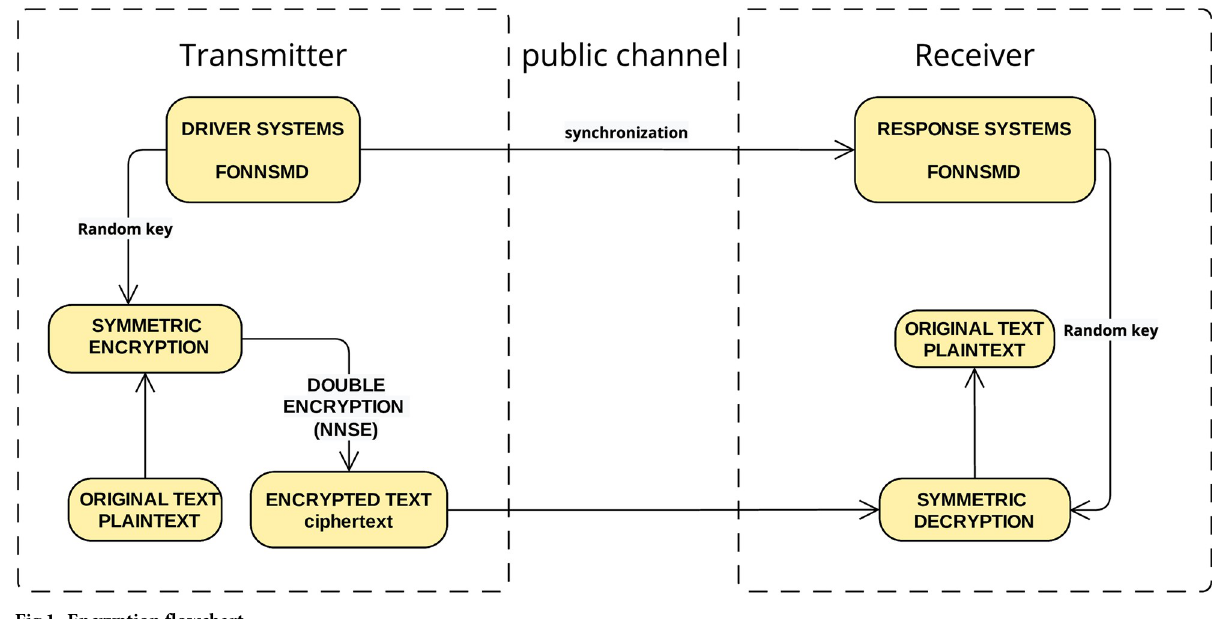
Fig 1. Encryption